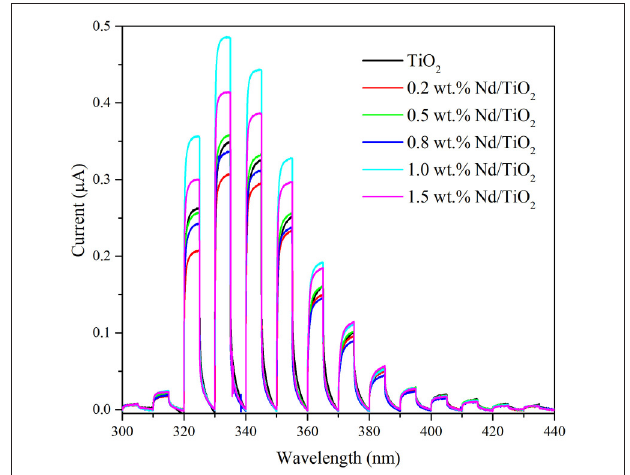
FIGURE 6 | Current generation in the presence of Nd/TiO 2 and parent TiO 2 photocatalysts at 1V vs. Ag/AgCl.